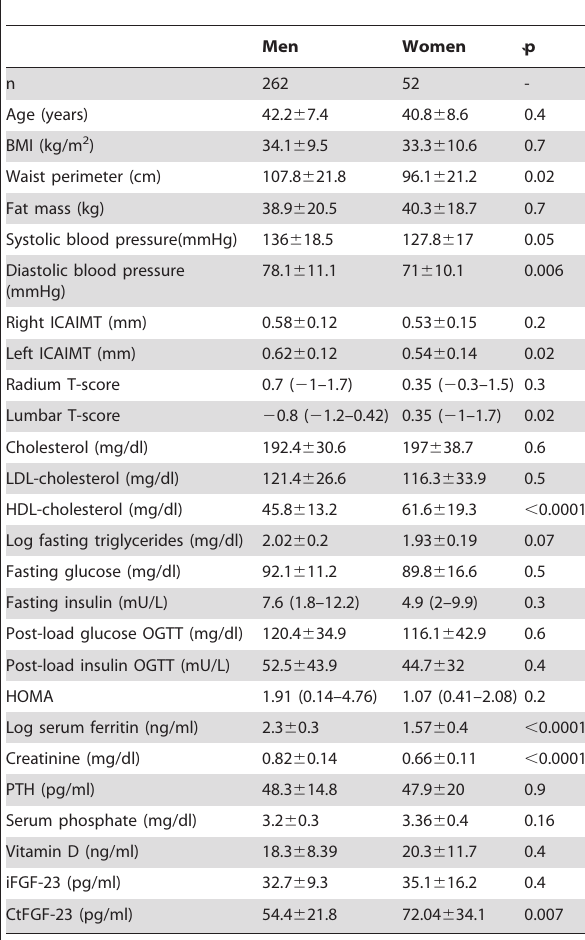
BMI , Body mass index; CRP , C reactive protein, iFGF-23 , fibroblast growth factor-23, CtFGF-23 , C-terminal FGF-23, ICAIMT , internal carotid artery intima media thickness, OGTT , oral glucose tolerance test; PTH , parathyroid hormone. Values are given as mean 6 SD or as median (interquartile range).